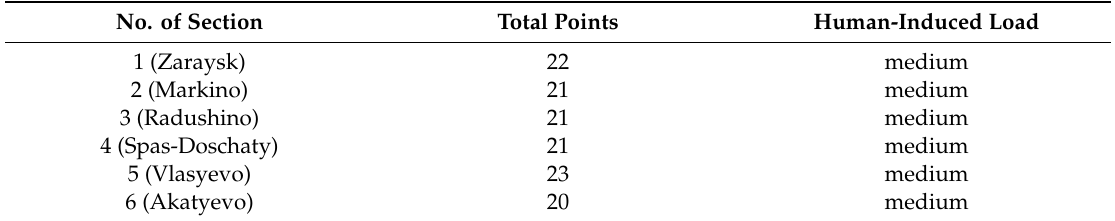
Table 5. Summary scale of the total human-induced load calculation within the surveyed sections. No. of